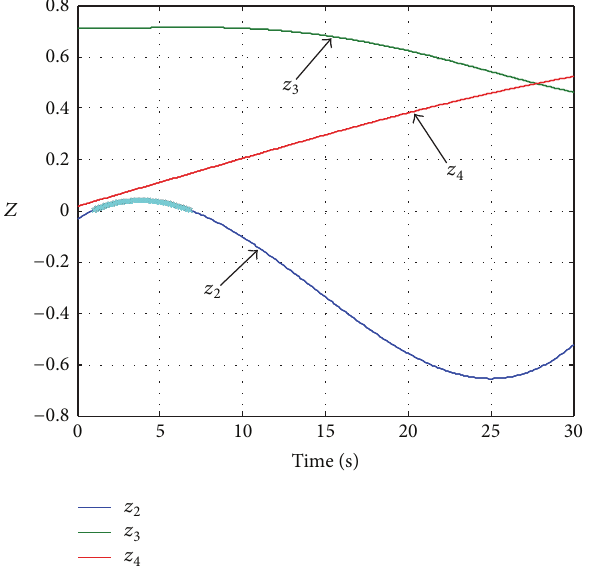
Figure 4: Chained form state 𝑧 . Figure 5: Chained form state